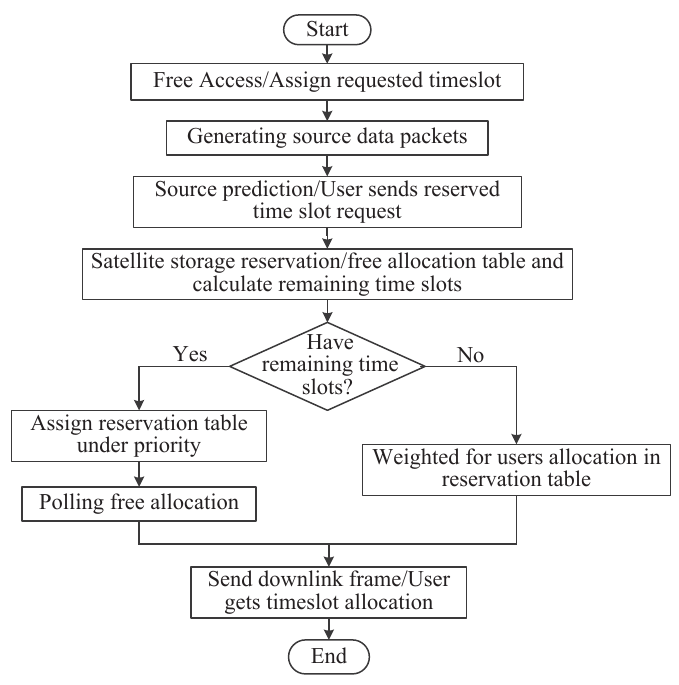
Figure 2. Flowchart of CFDAMA-GF.